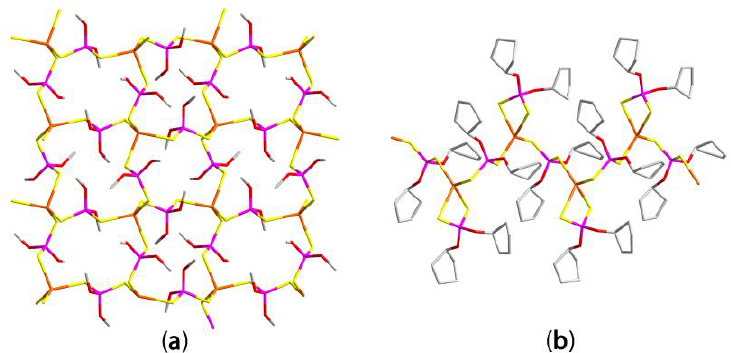
Figure 7. Aggregation in the crystals of ( a ) {Hg[S 2 P(OMe) 2 ] 2 } n ( 32 ) and ( b ) {Hg[S 2 P(O-c-Pentyl) 2 ] 2 } n ( 35 ).